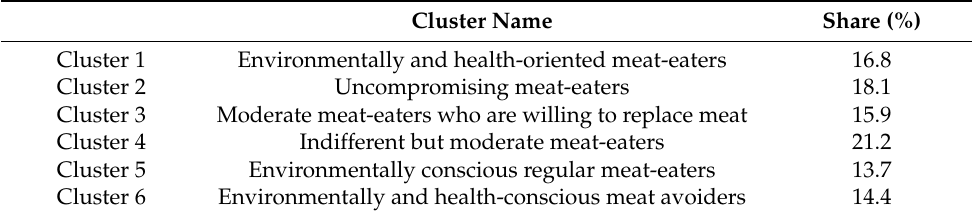
Table 2. Cluster names and shares.